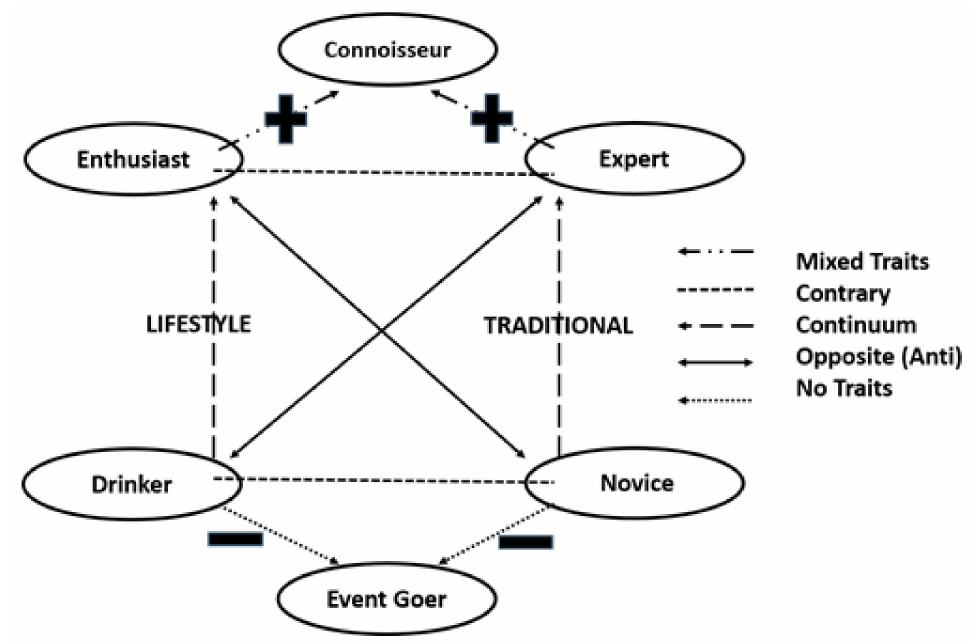
Figure 1. Semiotic Square Model for fine wine